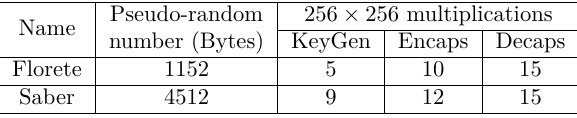
Table 1: Required pseudo-random bytes for generating public matrix ( A ) and secret vector ( s ), and number of 256 × 256 multiplications in Saber and Florete.